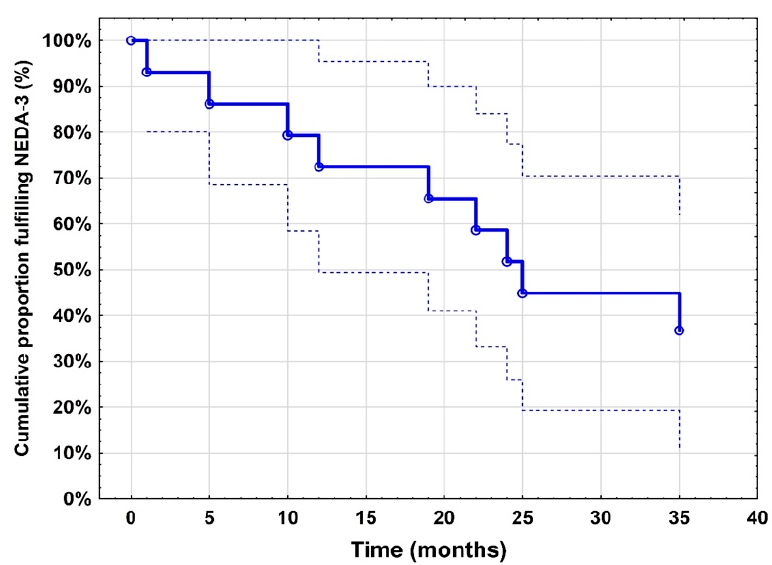
Figure 1. Kaplan–Meier curve showing sustained NEDA-3 fulfilment among the study cohort ( n = 14). NEDA: no evidence of disease activity.